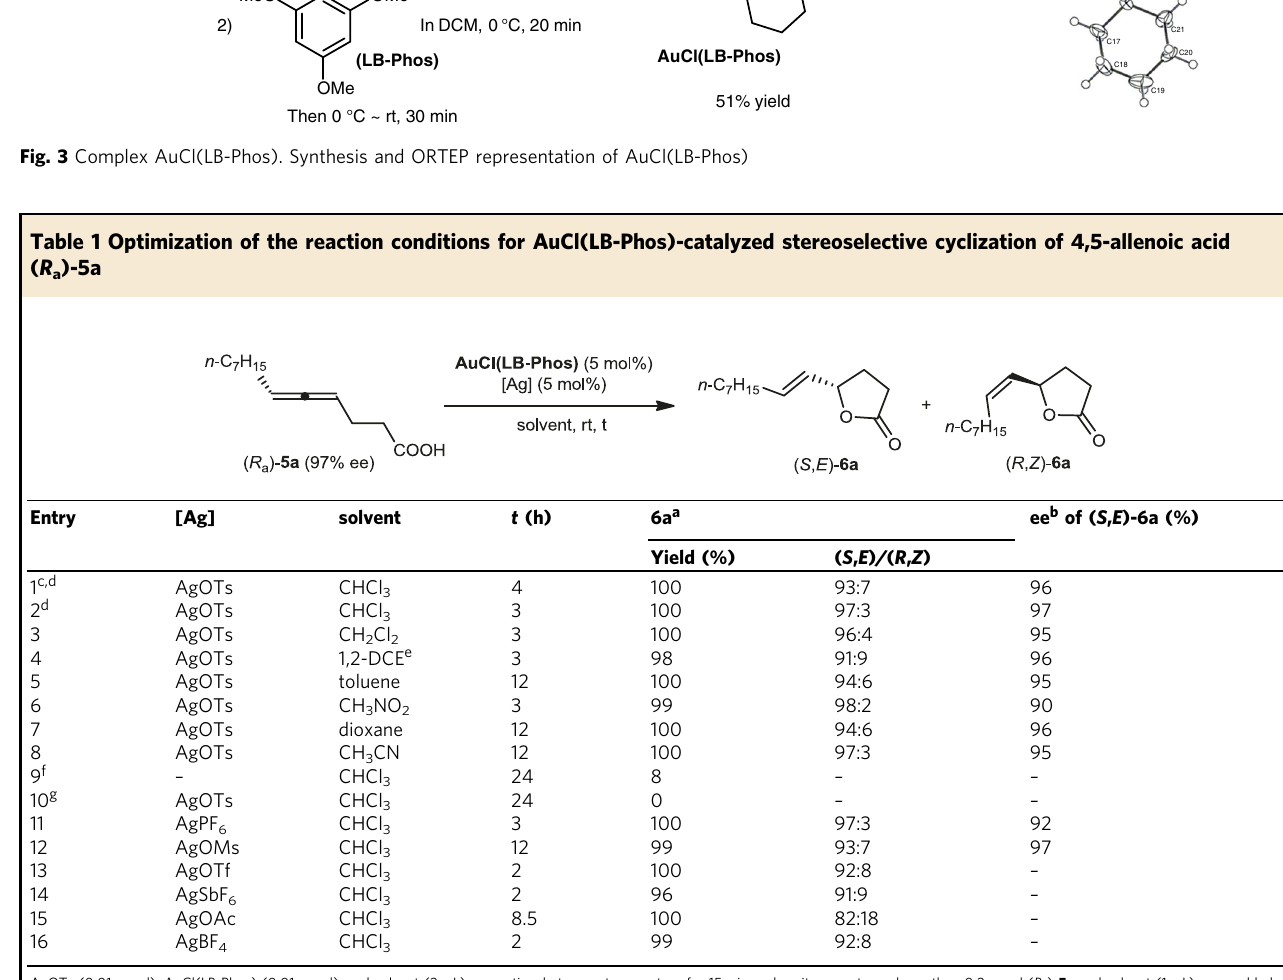
Table 2). Functional groups including benzyl group, C = C, and C ≡ C bonds were also tolerated ( 6f , 6g , 6h , and 6i ).